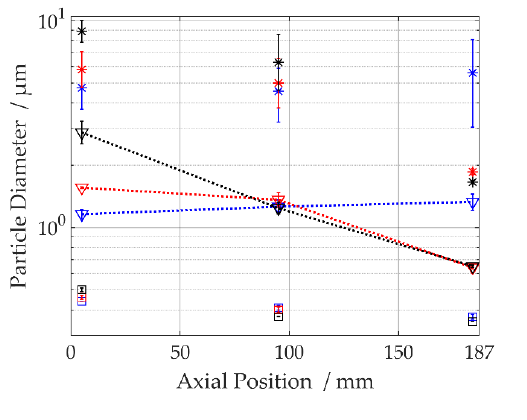
𝑥 50 with dashed lines as guides to the eye; stars: three cases over time; light color: Earliest measurement; darkening shade with progressing time until darkest color: Latest measurement.